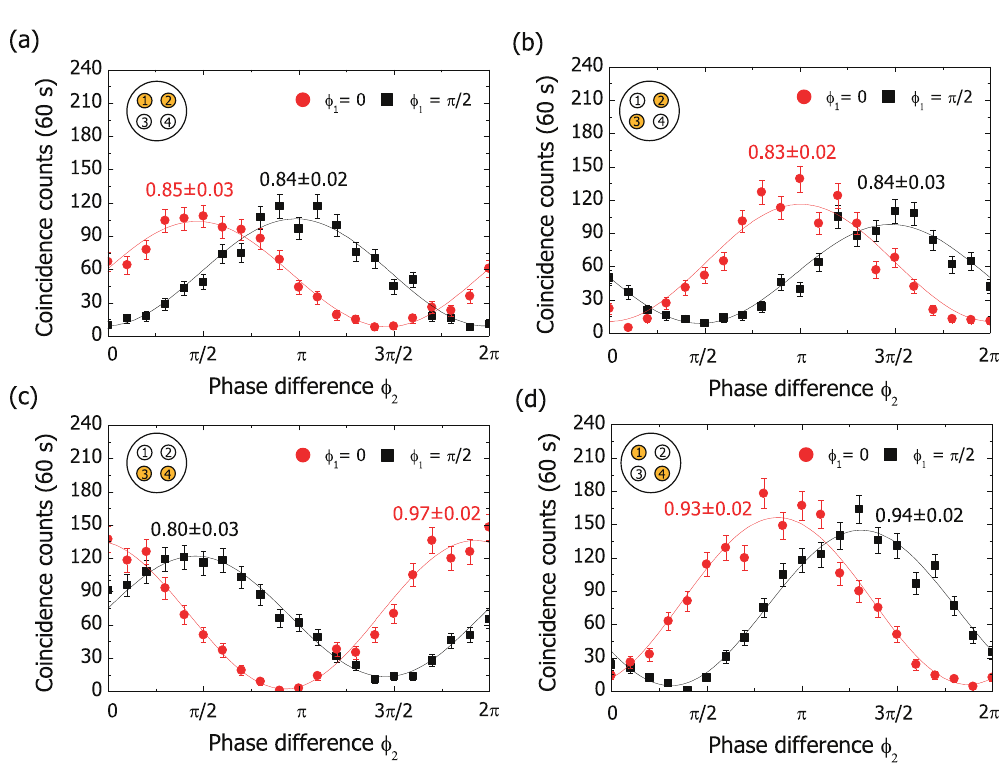
Figure 3. Correlations between two-core superposition states. Photons 1 and 2 are projected onto the states + φ i 4), ( d ) ( i , j ) = (4,